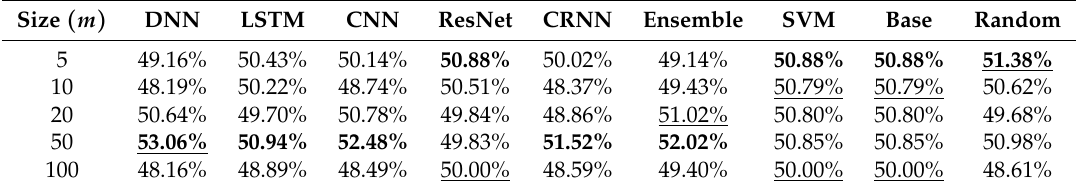
Table 5. Effect of the sequence size m on classification (accuracy). The log values of the major features, the sequential partitioning, and the first value-based normalization were used.